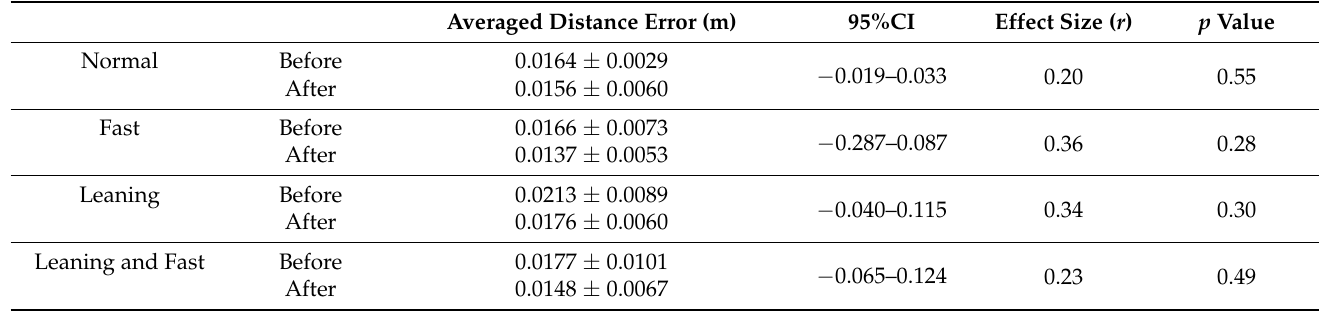
Table 4. Average distance error in the STG for heel in lateral obstacle crossing.